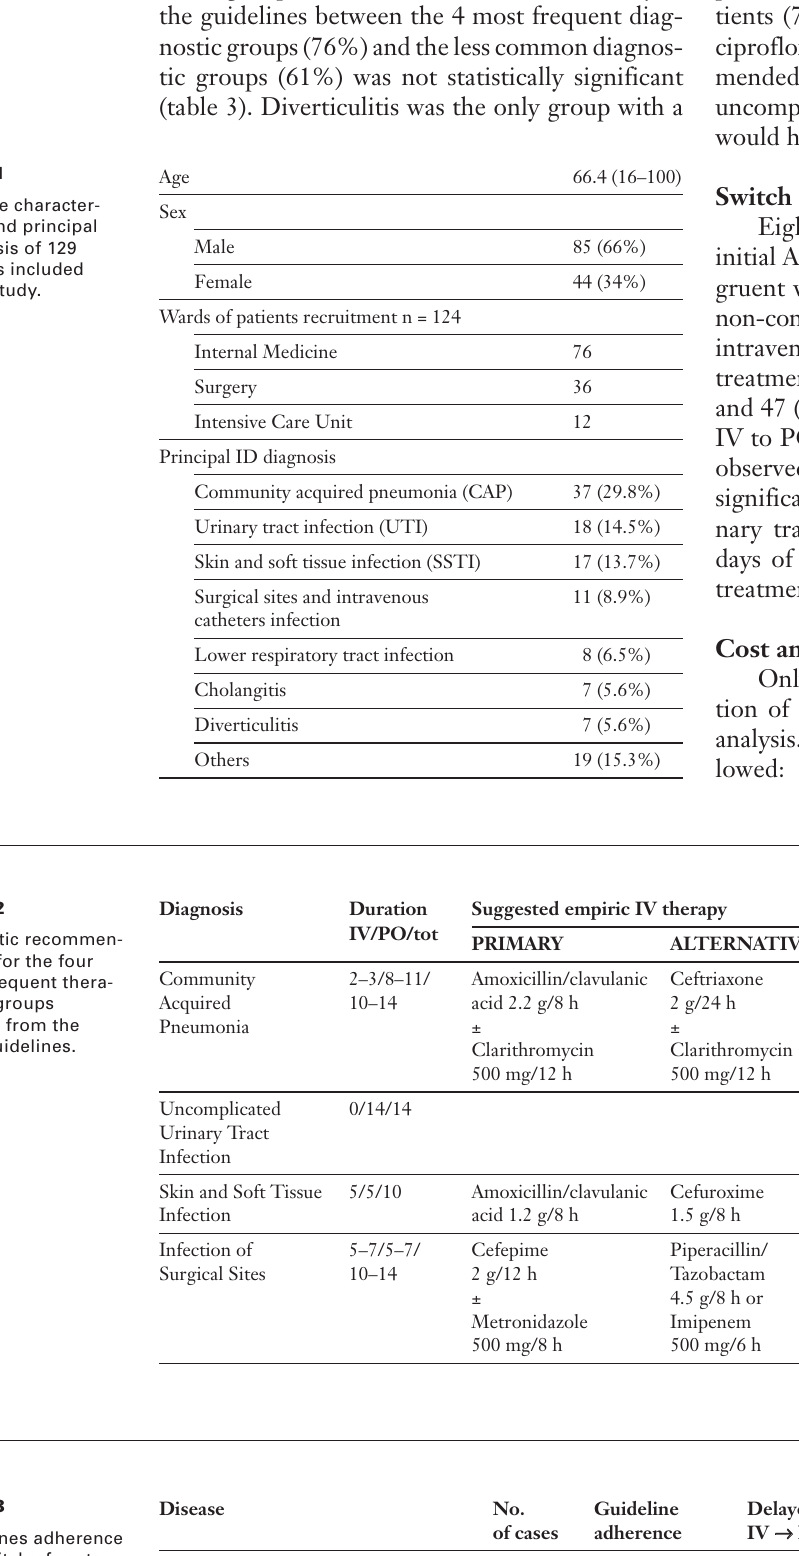
Guidelines adherence and switch of route of